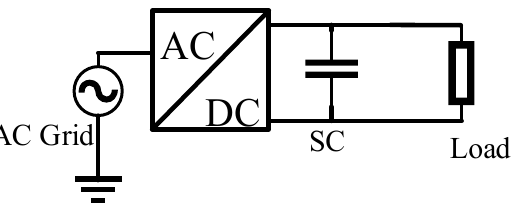
Figure 15. Schematic diagram of a parallel system of supercapacitors and loads.